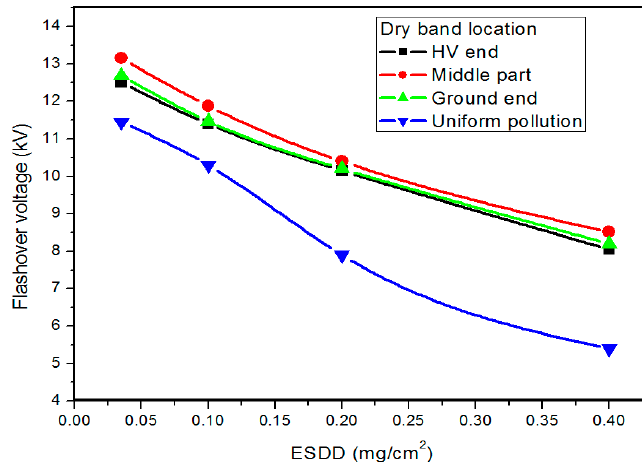
Figure 16. Flashover voltage at different dry band locations, where NSDD = 0.75 mg/cm 2 , humidity level = low, temperature = 10 °C, and standard deviation = 2.6%–6.3%.